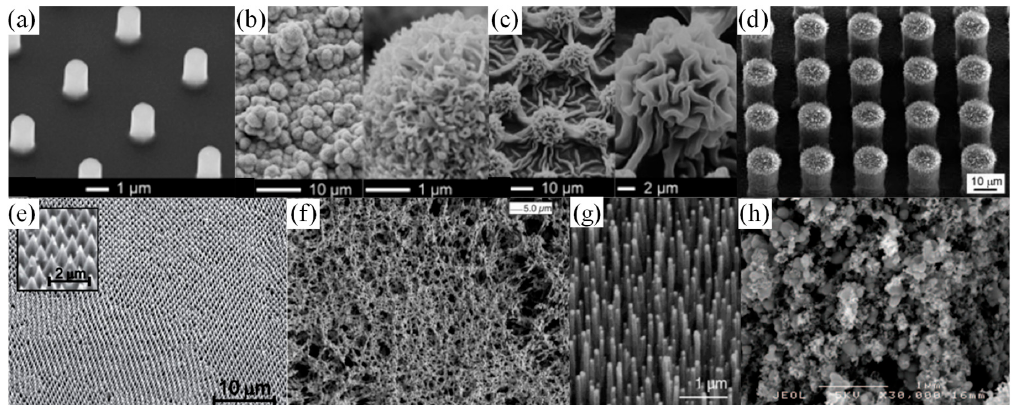
Figure 3. Artificial superhydrophobic surface examples imaged by scanning electron microscopy